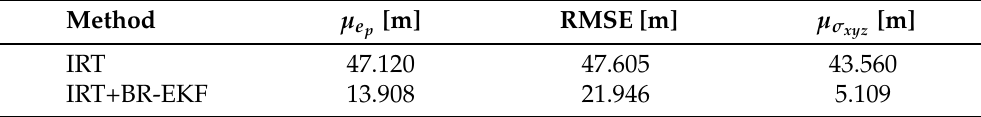
Table 10. Results from the Porto de Mós experimental procedure simulated with an aerial perspective.